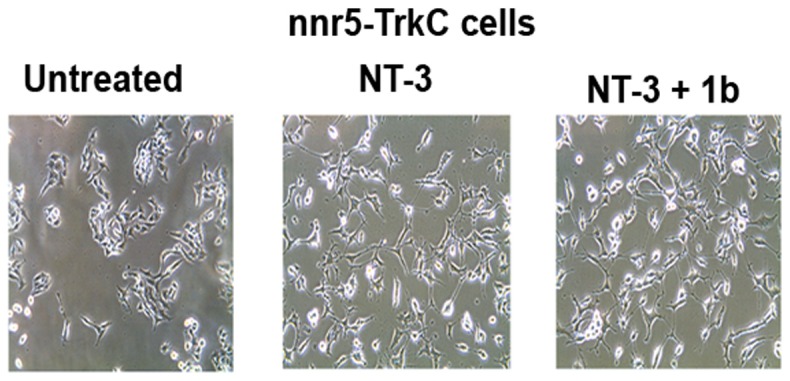
Antagonists do not affect ligand-dependent neuritogenesis.Cells expressing TrkC and p75 (nnr5-TrkC) were plated in full medium ± neurotrophin ± peptidomimetics (10 µM). Fields were photographed 72 h later. Neurite outgrowth was determined as percentage of cells with neurites (defined as length >2 cell bodies). Representative pictures from nnr5-TrkC for compound 1b are shown.